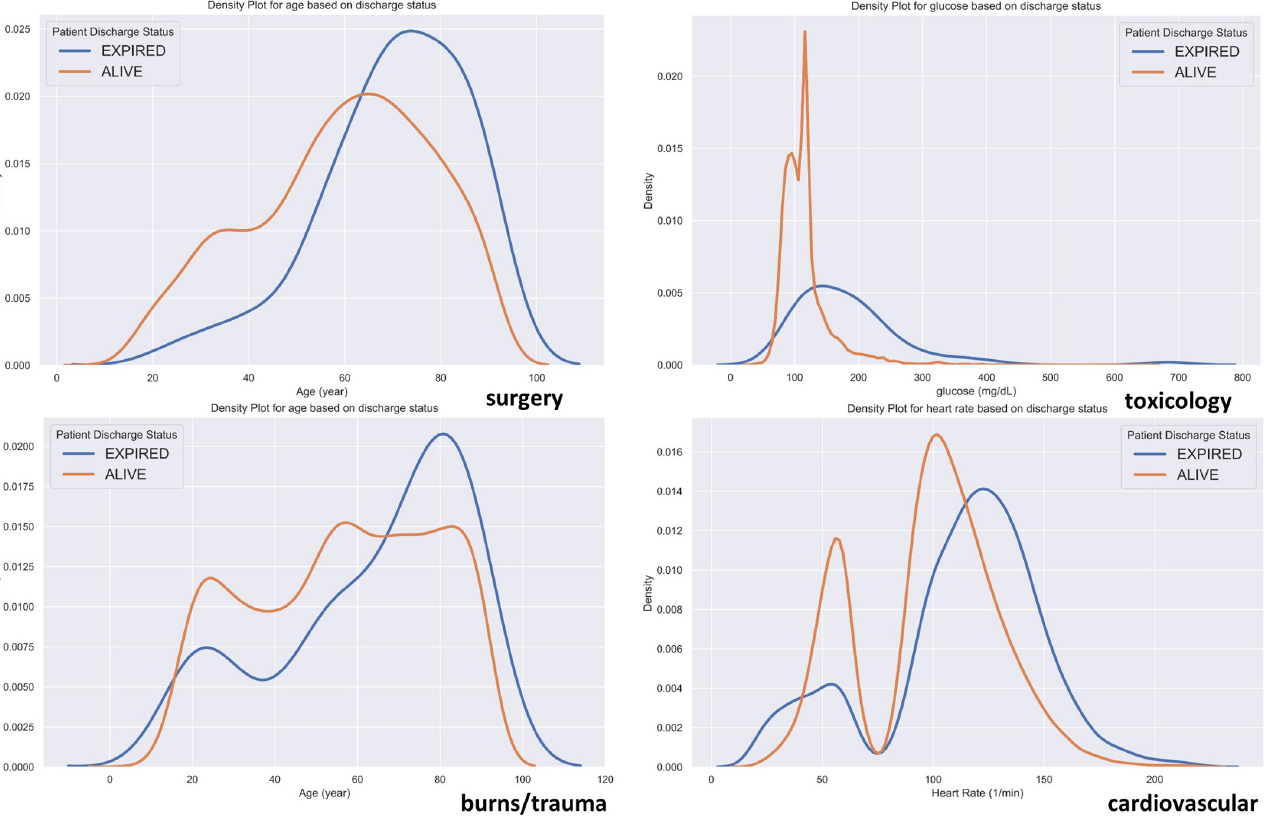
Fig 7. Bar and KDE plots for the most important features in predicting ICU discharge status for surgery, toxicology, burns-trauma, and cardiovascular disease groups.